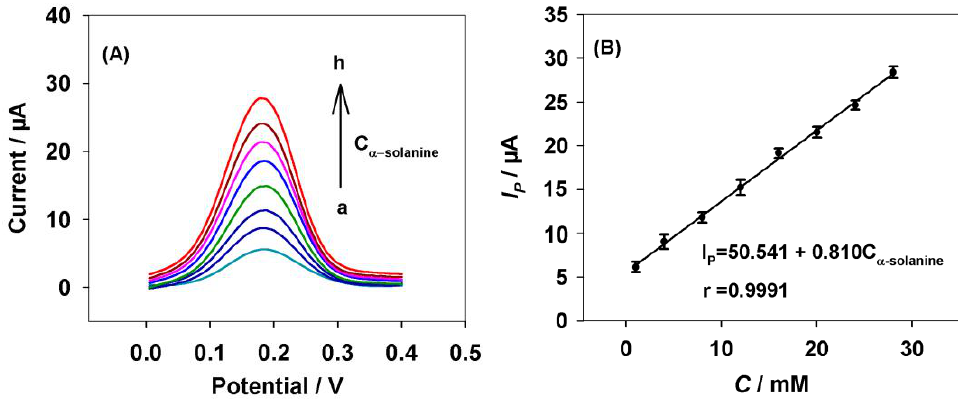
Figure 4. DPV responses of α-solanine at the CNTs-PBA/GC electrode. ( A ) DPV responses on the CNTs-PBA/GC electrode after incubated with different concentration of α-solanine, recorded in PBS (0.1 M, pH 7.2) containing [Fe(CN) ( B ) Plot of the peak current versus the concentrations of